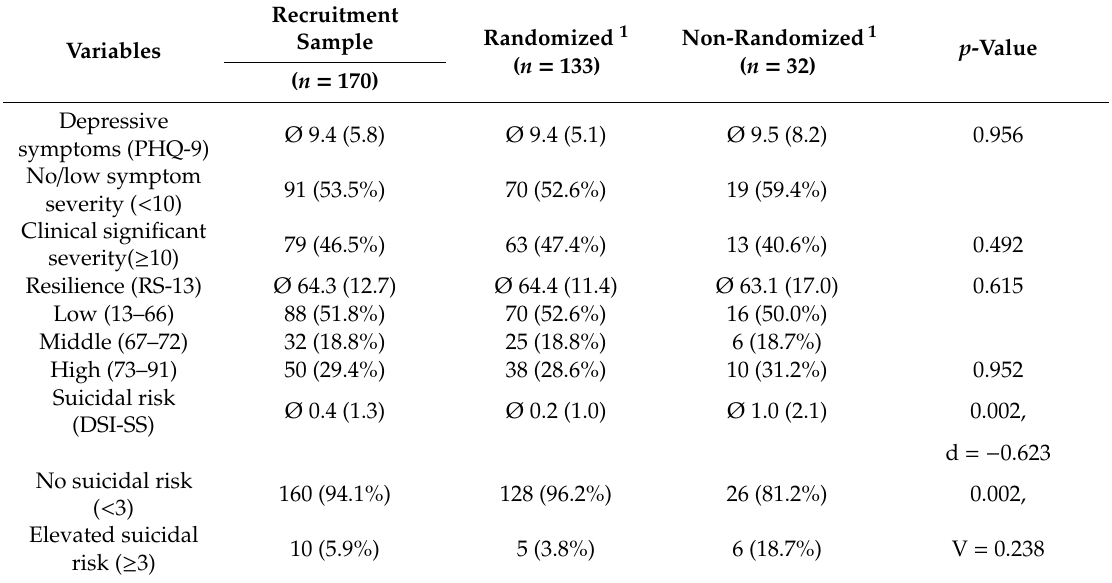
Table 3. Secondary mental health characteristics of the recruitment sample screened for eligibility in the “Sanadak” trial with regard to randomization